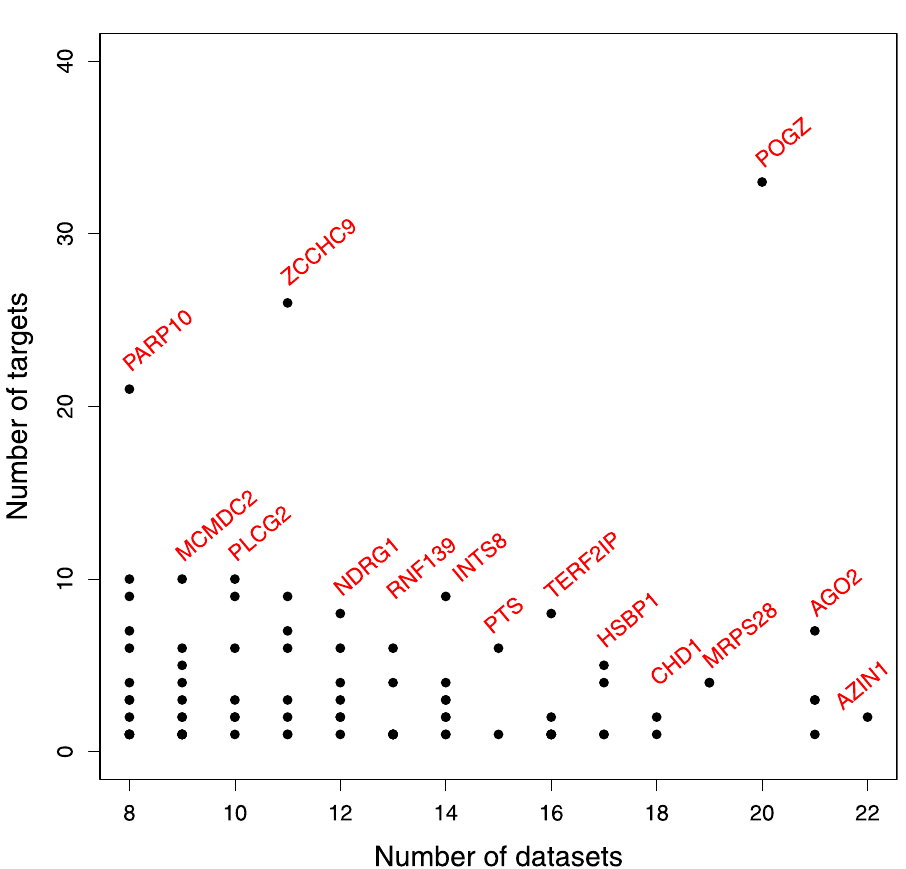
Fig 4. For regulators, number of significant best targets against number of datasets. For each regulator, plotting the number of their predicted significant best targets against the number of datasets in which they show significant self aCGH/expression correlation. Showing only regulators with self-correlation in 8 or more datasets and regulators with at least one enriched pathway. The regulator with the maximum number of targets at each number of datasets is